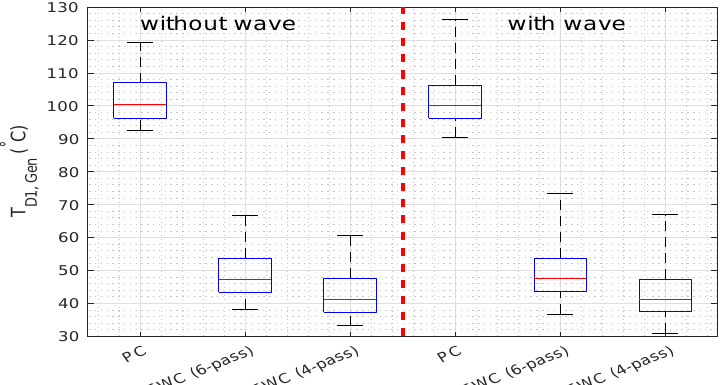
Figure 23. Diode junction temperature swing for different cooling systems at mean velocity of 3.3 m/s and TI value of 13%. Temperature swing is shown without waves and with a wave of H s = 5.75 m and T p = 11 s. For different cooling systems with same wave conditions, the temperature swing is nearly the same, albeit with a difference in mean temperatures. However, for the same cooling system, with and without waves, the mean temperature is the same but with a difference in temperature swing. PC—passive cooling; FWC—forced-water